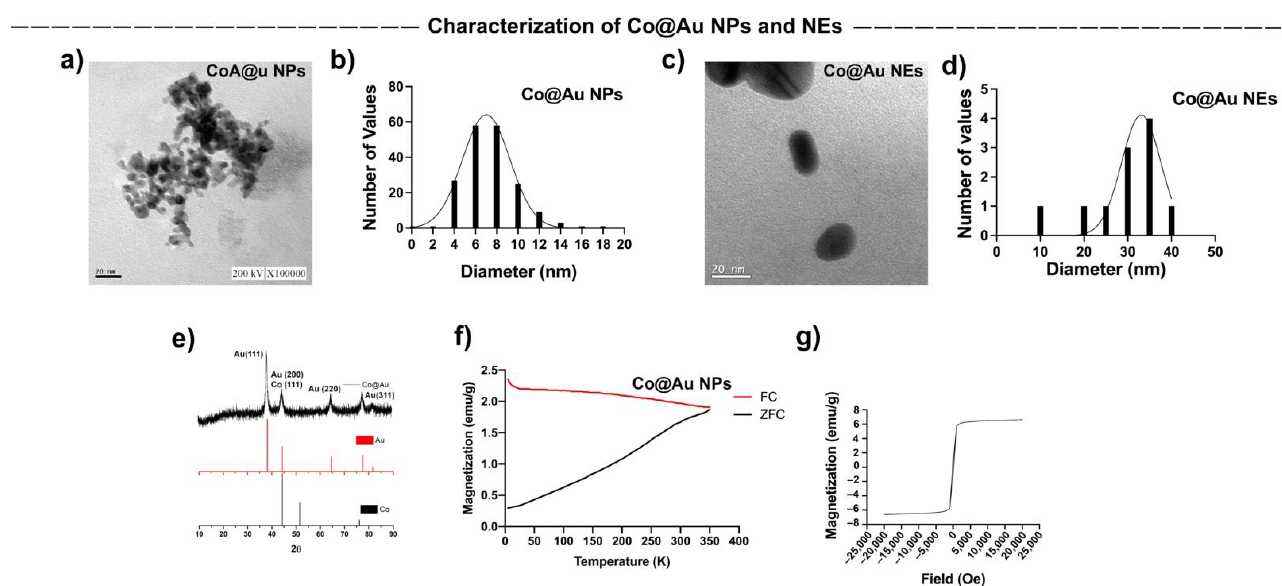
Figure 1. Characterization of round Co@Au nanoparticles (Co@Au NPs) and elliptical Co@Au (Co@Au NEs) nanoparticles. ( a ) TEM micrograph of spherical Co@Au NPs. Scale bar = 20 nm. ( b ) Representation of size distribution of Co@Au NPS. x -axis highlights the diameter; y -axis highlights the size frequency. The number of particles analyzed was 184. ( c ) TEM micrograph highlighting elliptical-shaped Co@Au NEs. Scale bar = 20 nm. ( d ) Representation of size distribution of Co@Au NEs. x -axis highlights the diameter; y -axis highlights the size frequency. The number of particles analyzed was 11. ( e ) XRD analysis highlighting 2θ peaks corresponding to crystal structures of Co@Au NPs. ( f ) Analysis of magnetic properties of Co@Au NPs. x -axis highlights temperature; y -axis highlights magnetization. ( g ) Analysis of magnetic properties of Co@Au NPs. x -axis highlights magnetic field strength; y -axis highlights magnetization.